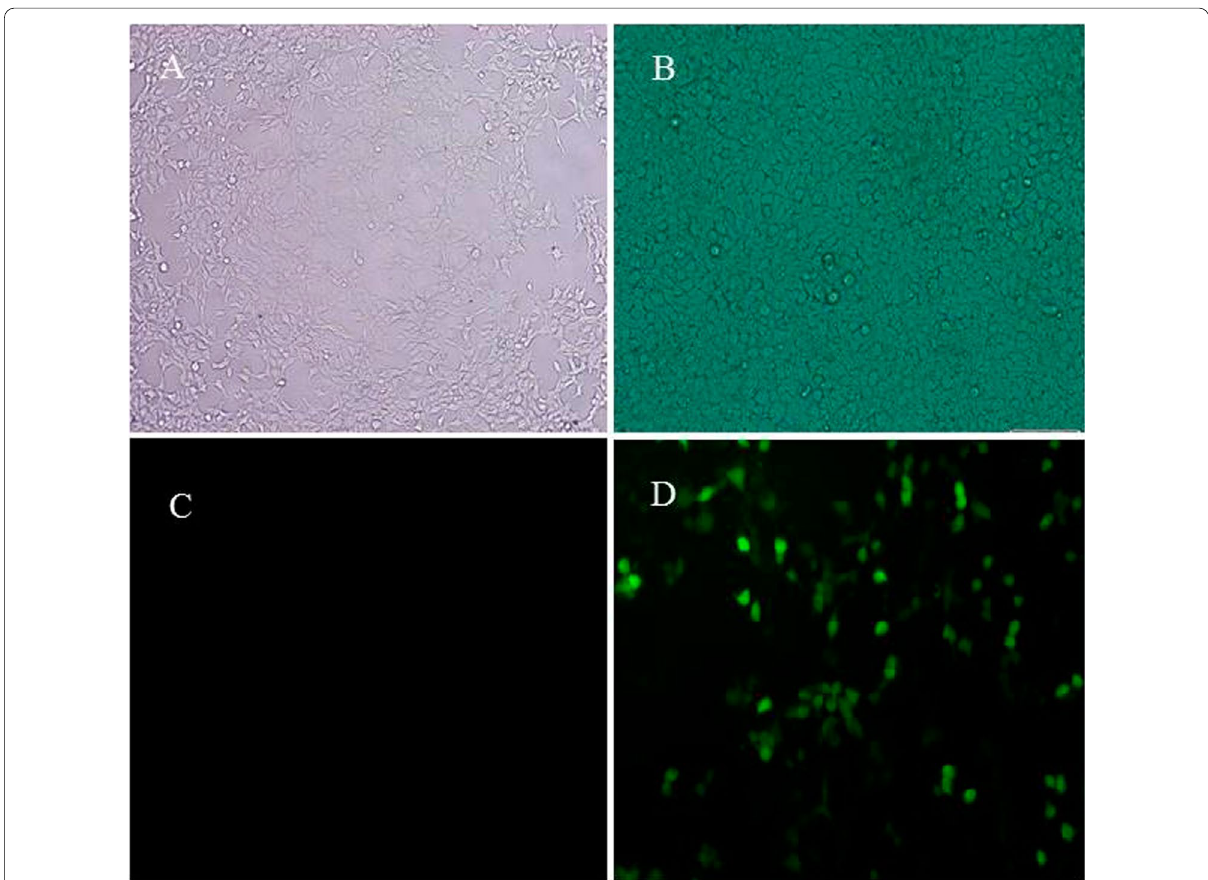
Fig. 2 The GFP protein expression of HEK293 cells following transfection. The transfection was carried out using Lipofectamine reagents. This figure illustrates a small proportion of the total cells, absorbing the vectors containing the gRNAs. A Untransfected HEK293T cells with UV visible. B Transfected HEK293T cells with UV visible. C Untransfected HEK293T cells with GFP − . D Transfected HEK293T cells with GFP